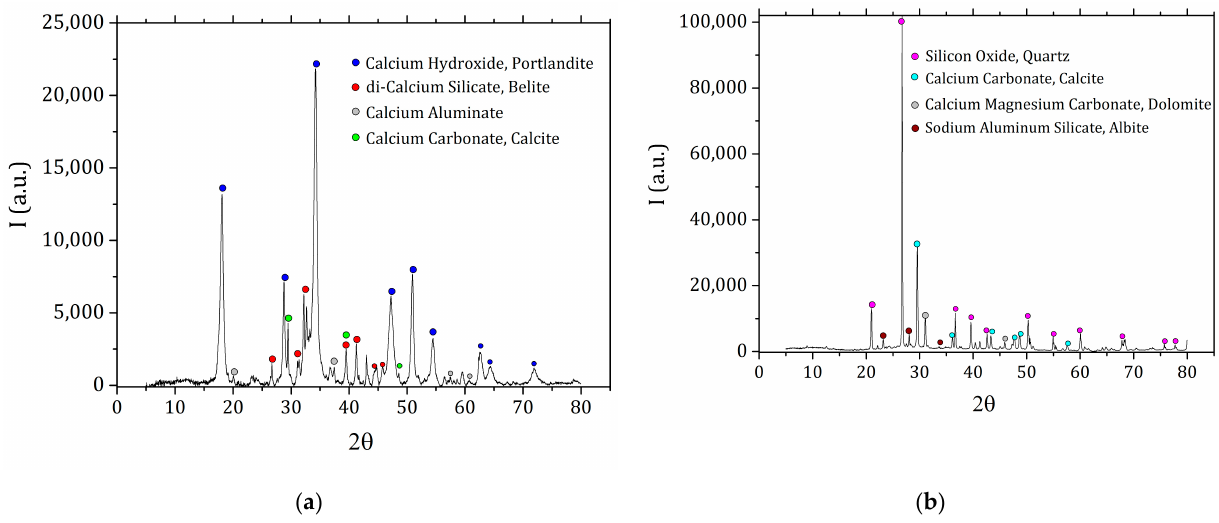
Figure 1. X-ray diffraction patterns on the raw materials: NHL5 ( a ) and quarry sand ( b ). Fibrillated